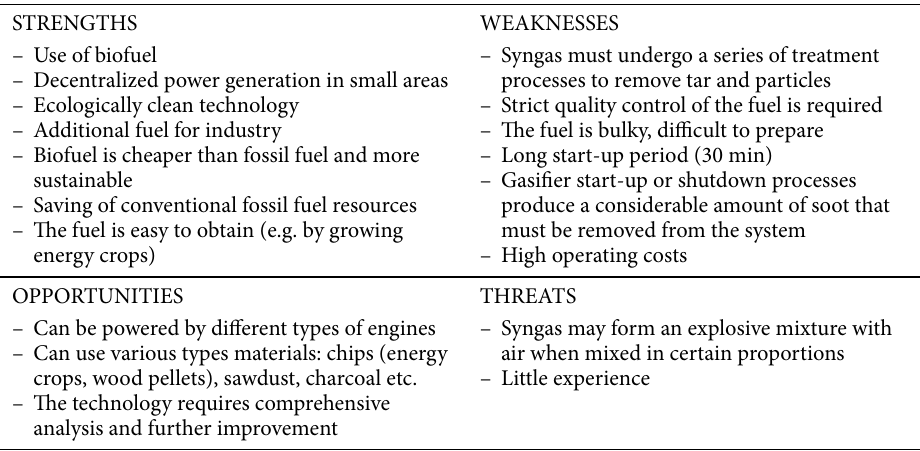
Table 4. Gasification: SWOT